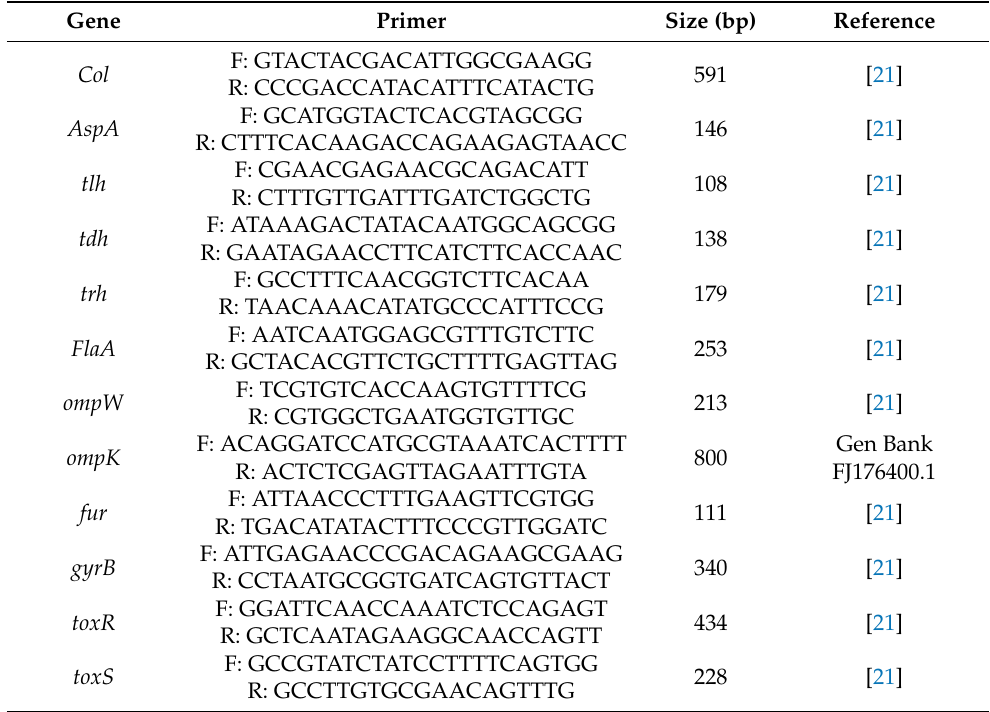
Table 1. Primers used in this study for amplification of virulent genes of V. alginolyticus . Gene Primer Size